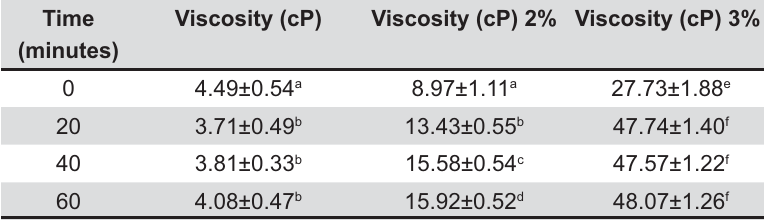
Table 2- Effect of time on the viscosity of infant powdered milk maintained at 37°C